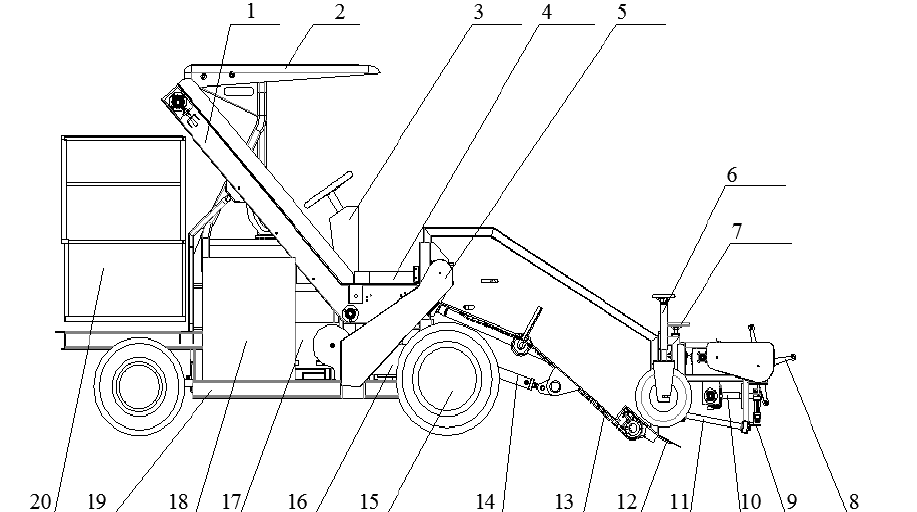
Figure 1. Structure diagram of garlic combine harvester of cut–dig type under 4DS-1200 model. Note: 1. lateral conveying device; 2. driving shed; 3. manipulation system; 4. lateral conveying device; 5. chain transmission mechanism; 6. profile depth limitation device; 7. position adjustment device dial wheel; 8. dial wheel; 9. reciprocating cutter; 10. swing rod; 11. transverse conveying device of garlic seedling; 12. mining shovel; 13. lifting chain; 14. hydraulic cylinder; 15. driving wheel; 16. hydrostatic driving system; 17. transmission; 18. power system; 19. vehicle bridge; 20. stock bin.